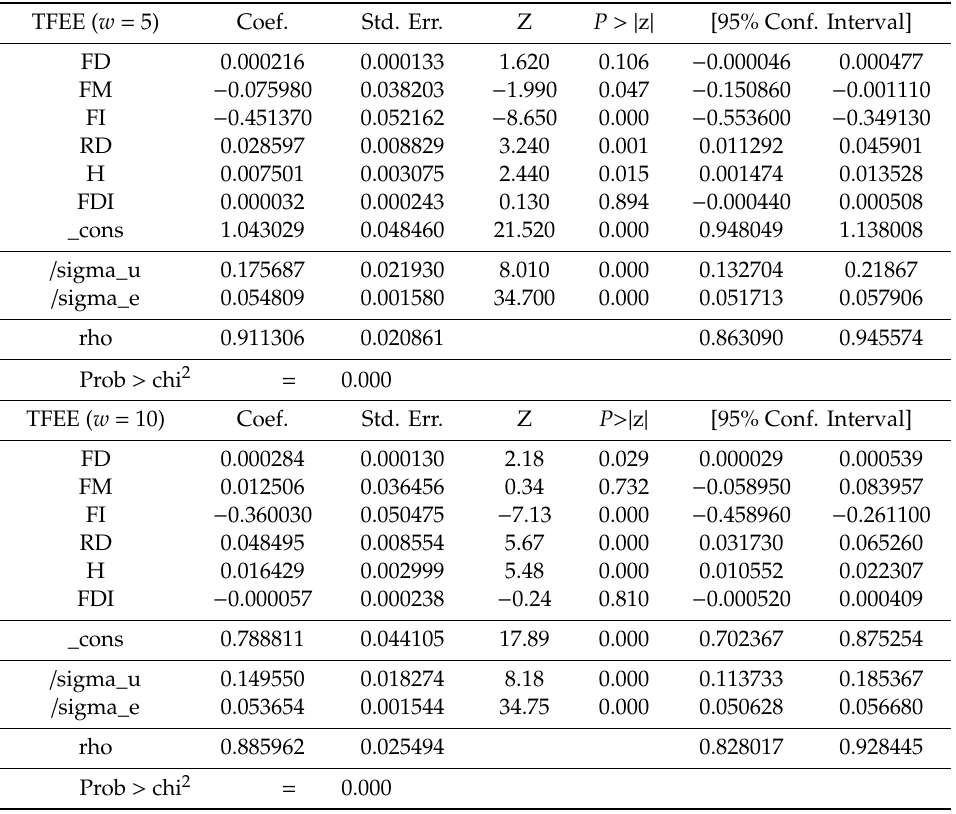
Table 8. Tobit regression model results for sustainable financial development variable